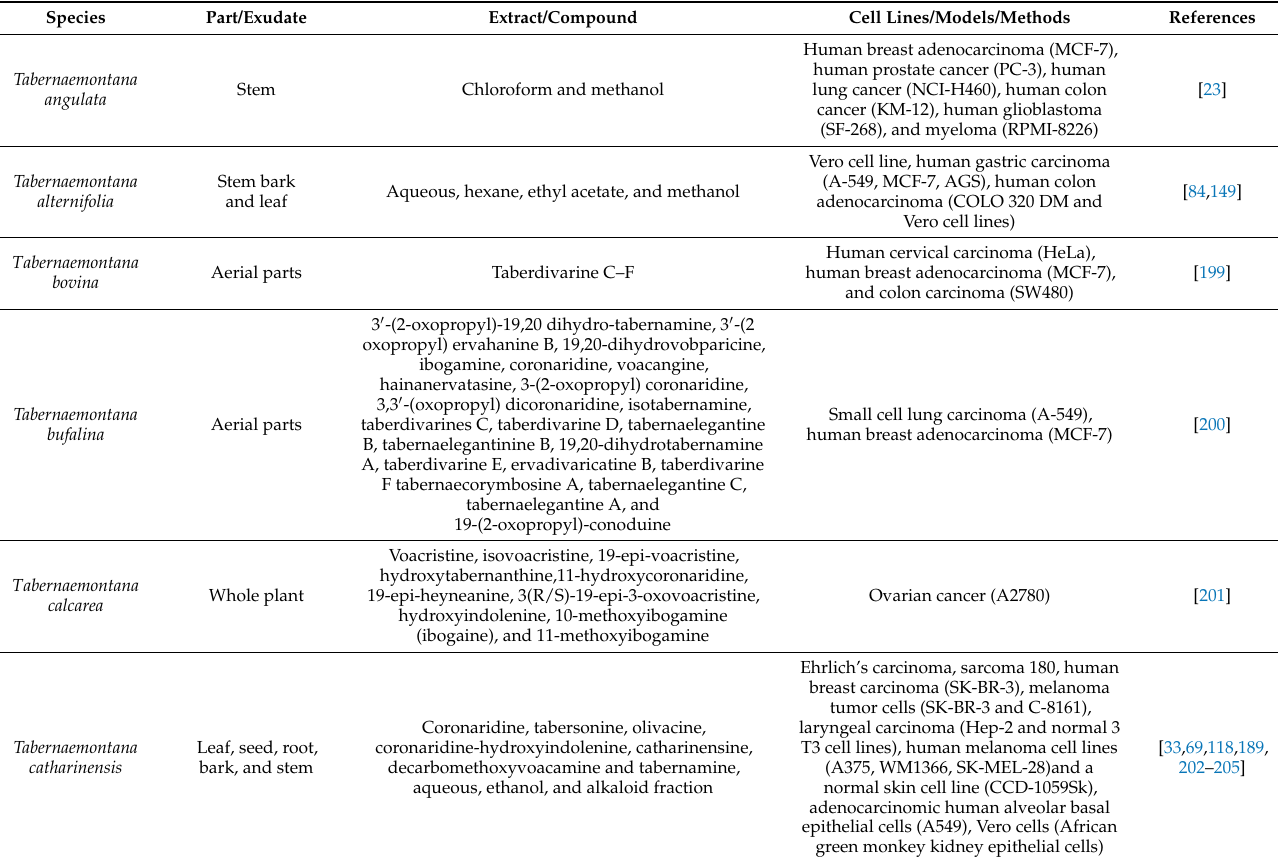
Table 8. Anticancer activities of extracts and compounds isolated from Tabernaemontana